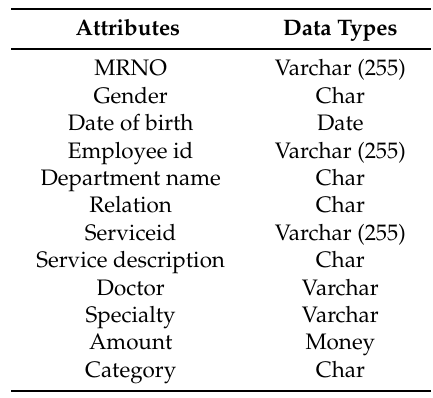
Table 3. Each transaction’s Attributes in data set.